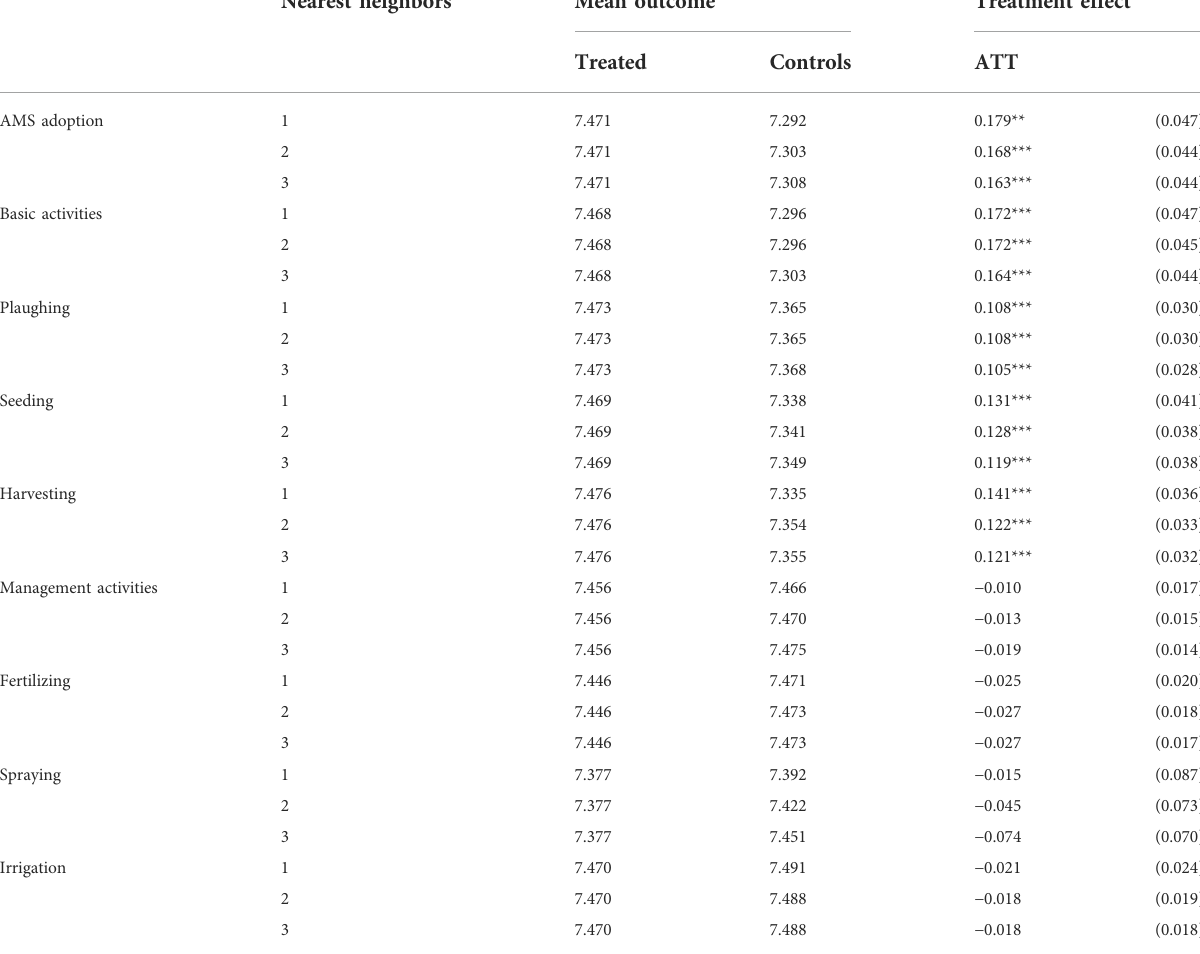
TABLE 4 Average treatment effect of AMS adoption on land productivity by